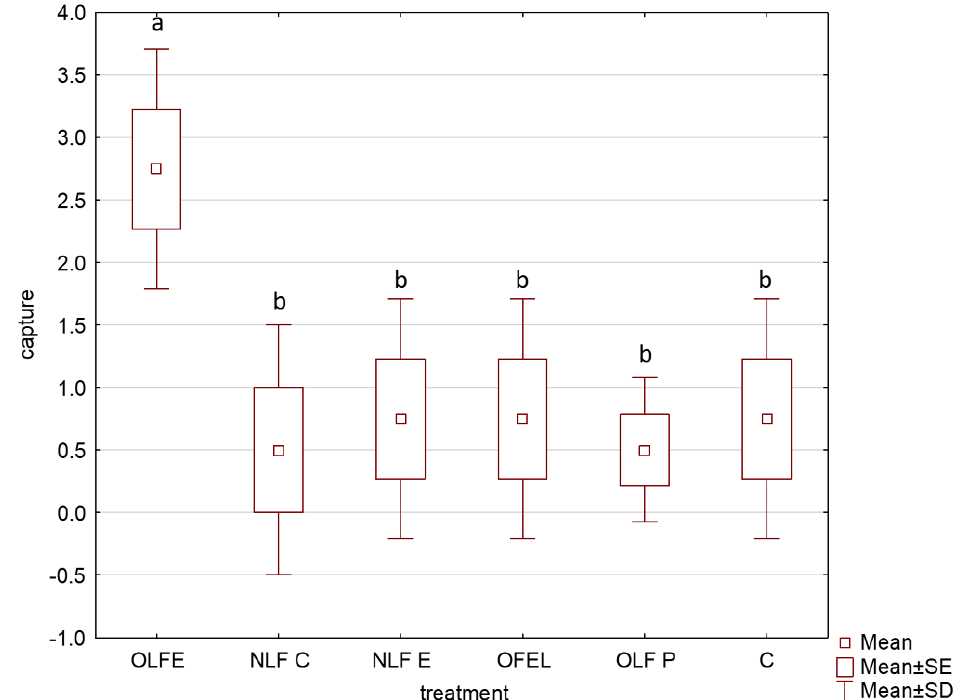
Figure 1. Number of male CPB captured with various lychee-derived products in a two-week field test. OLFE—Organic Lychee Flavor Extract, NLFC—Natural Lychee Flavor Concentrate, NLFE—Natural Flavor Lychee Emulsion, OFELL—Organic Fragrance Emulsion Lychee Love, OLFP—Organic Lychee Flavor Powder. Four replicates for each treatment were tested. Boxes presenting different letters are significantly different.